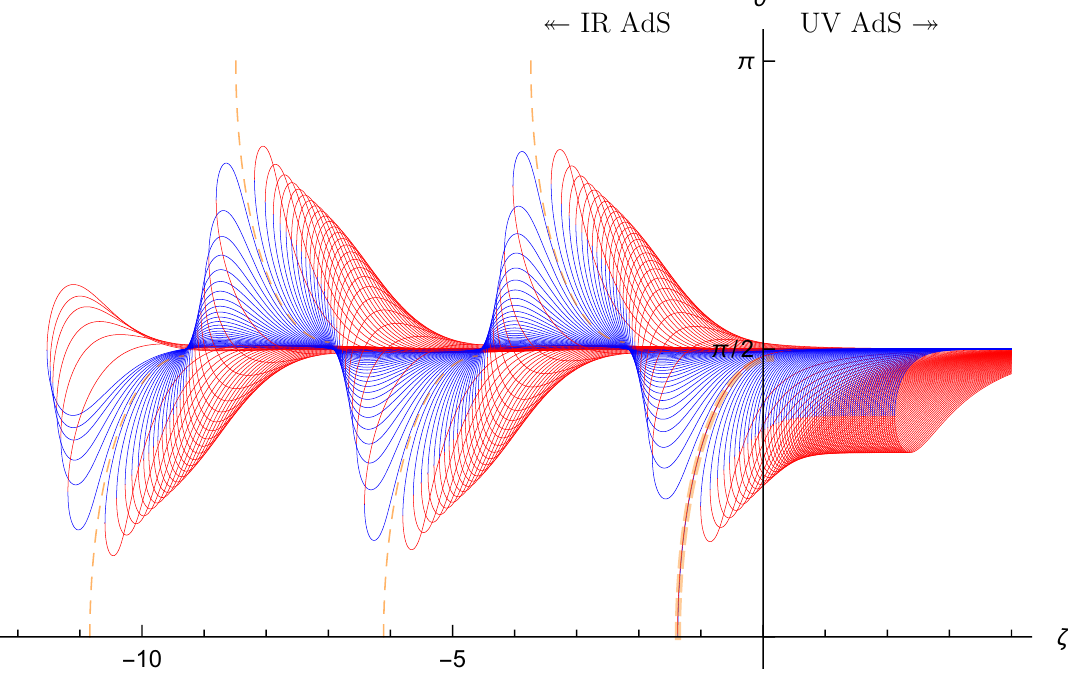
Figure 3 . Intermediate regime numerical solutions with varying values of (cid:18) 0 ( (cid:16) max ), taking (cid:16) max = 4. The surfaces plotted are the part of the subset that approach the a = 4 linearised solution, such that they are candidate minimal surfaces. The blue section of a curve shows where the surface move inwards from (cid:16) max , the red section where it moves outward. Equivalent (cid:13)ipped solutions (cid:18) 0 ! (cid:25) (cid:0) (cid:18) 0 are not shown for clarity. Orange dashed lines are truncated series solutions of (4.3), showing the discrete values of (cid:18) 0 ( (cid:16) max ) for which the surface reaches (cid:18) 0 = 0. The thickest orange line hitting (cid:18) 0 = 0 at (cid:16) min = (cid:0) 1 : 37, through which one numerical solution passes, shows the true minimal surface which approaches (cid:18) 0 = (cid:25)= 2 at large (cid:16) in this LLM